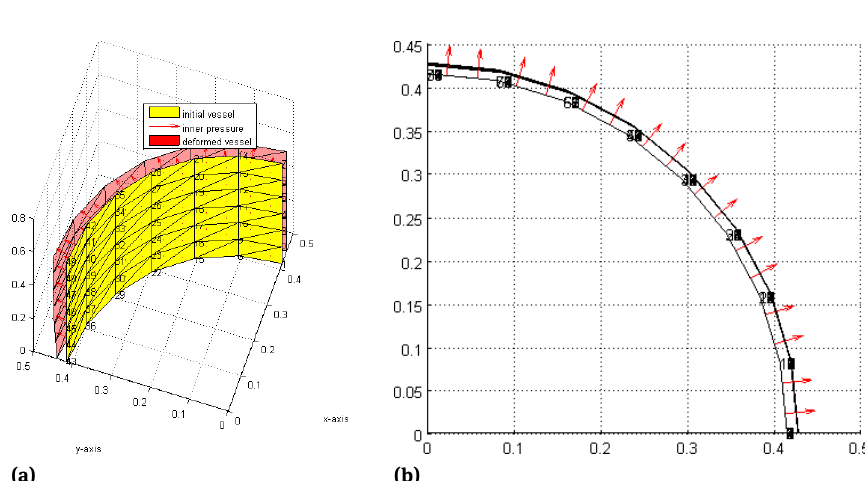
Figure 13: Thick walled cylinder [1]